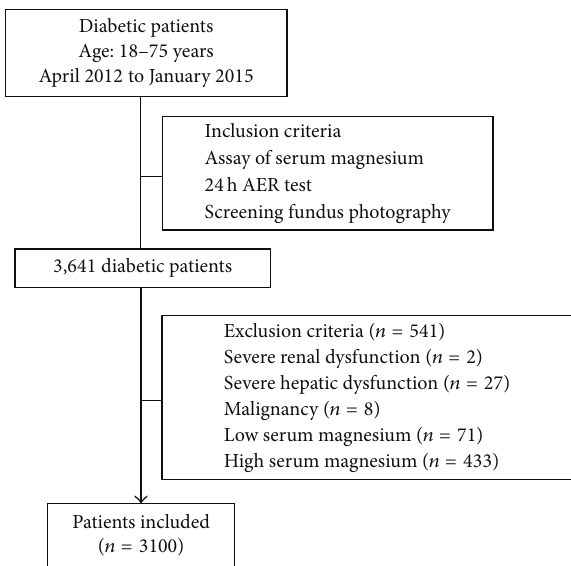
Figure 1: Flowchart of patient